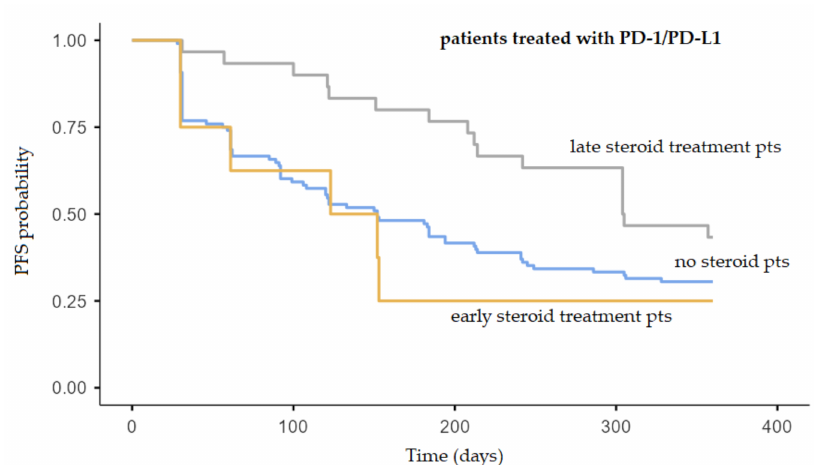
Figure 1. Association between steroid treatment for an irAE during the first 30 days of immunother- apy (“early treatment”), after 30 days (“late treatment”) and outcome in patients treated with anti-PD- 1/PD-L1. Late steroid treatment pts vs. non-steroid pts: log-rank p = 0.045; early steroid treatment pts vs. non-steroid pts: log-rank p = 0.358). Kaplan–Meier graphs of PFS. PFS = progression-free survival; pts =